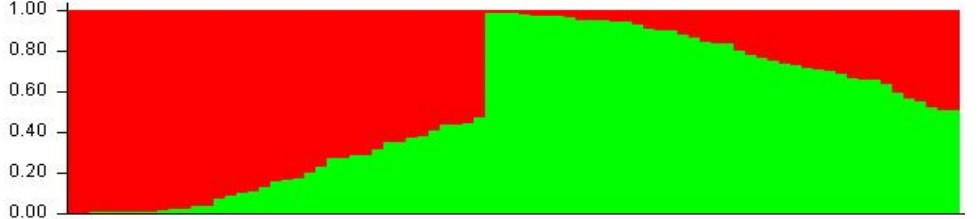
Figure 3. Inferred clusters in the 79 jujube cultivars (and synonymous groups) using STRUCTURE in the overall analyzed jujube accessions. Each vertical line represents one individual multilocus genotype. Individuals with multiple colors have admixed genotypes from multiple clusters. Each color represents the most likely ancestry of the cluster from which the genotype or partial genotype was derived. Clusters of individuals are represented by colors. Table 4. Q-values based on Bayesian stratification of 79 Chinese jujube cultivars from Ningxia, China.